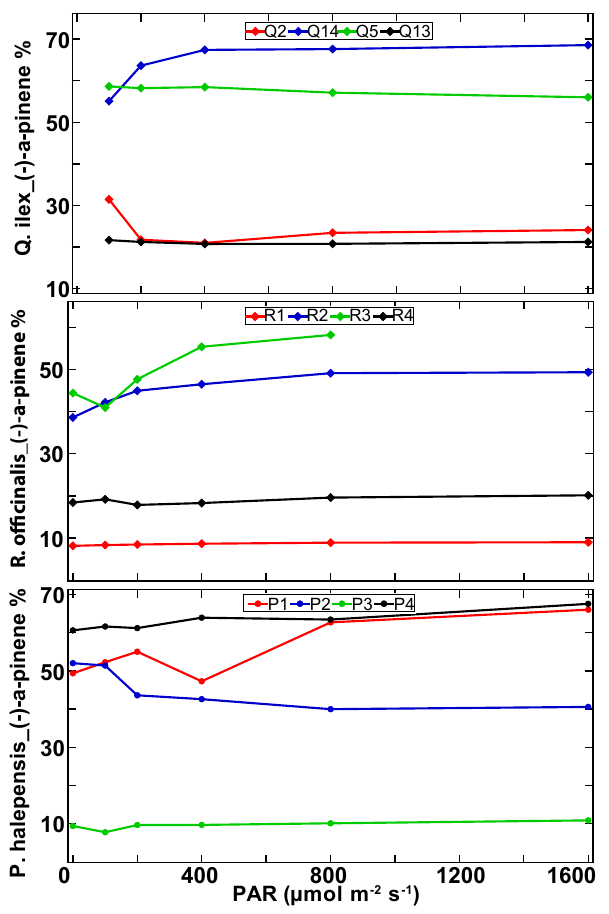
Fig. 5. Enantiomeric fraction of ( − )- α -pinene of Quercus ilex , Ros- marinus officinalis and Pinus halepensis as a function of light.